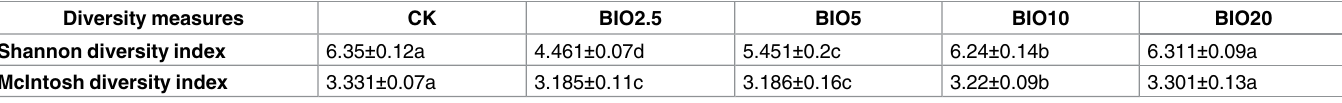
a All values are the mean of three replicates. Numbers followed by “ ± ” represent the standard errors. b Values with different letters after the number in the same row are significantly different at P < 0.05 according to Duncan’s